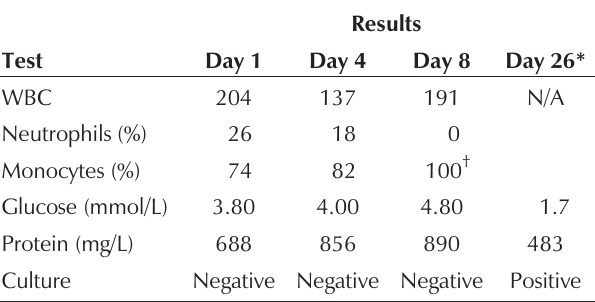
TABLE 1 Cerebral spinal fluid findings